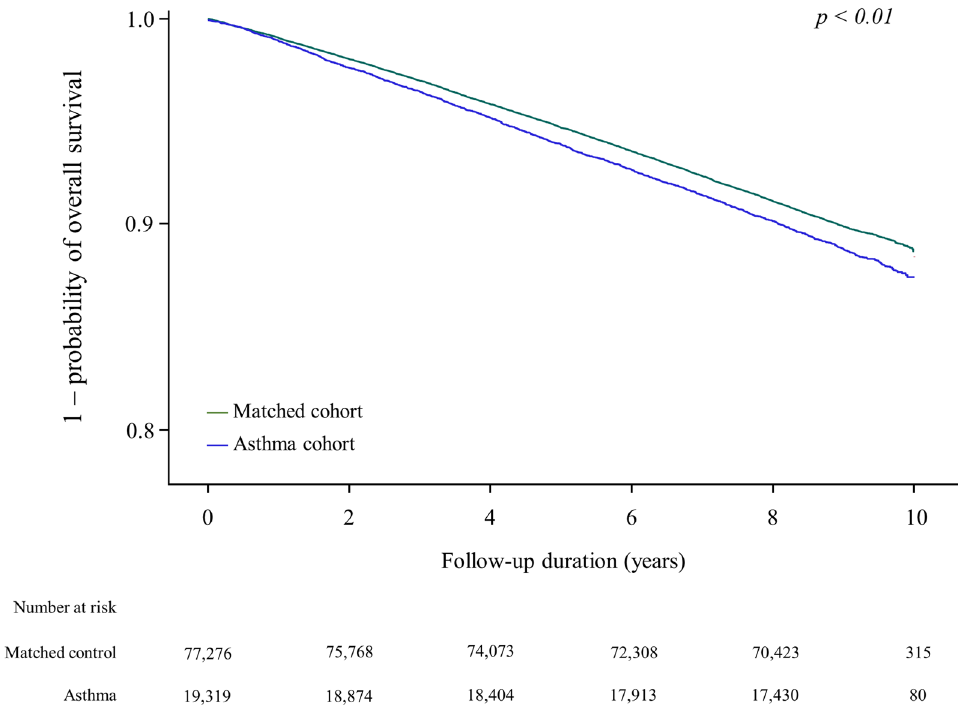
Figure 1. Kaplan–Meier survival plot of time to death in the asthma cohort versus the control